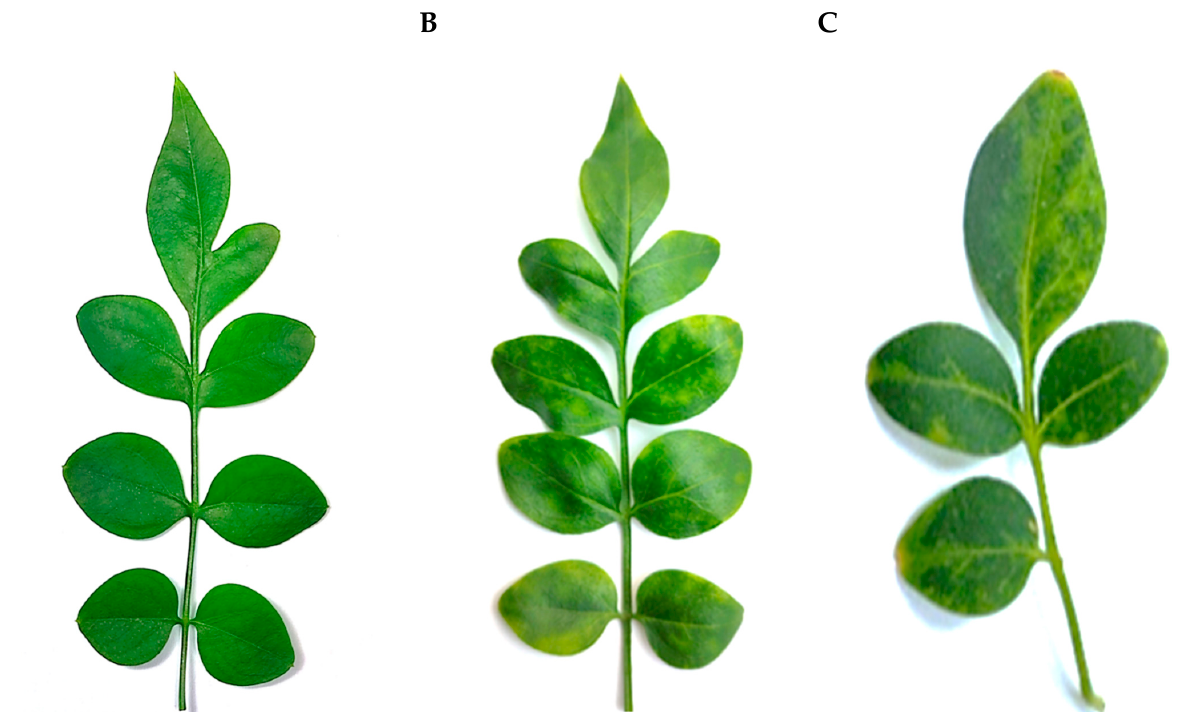
Figure 4. Leaves of Jasminum officinale showing symptoms of yellow spots and chlorotic variegation ( B , C ) and leaf of a healthy plant without symptoms ( A ).